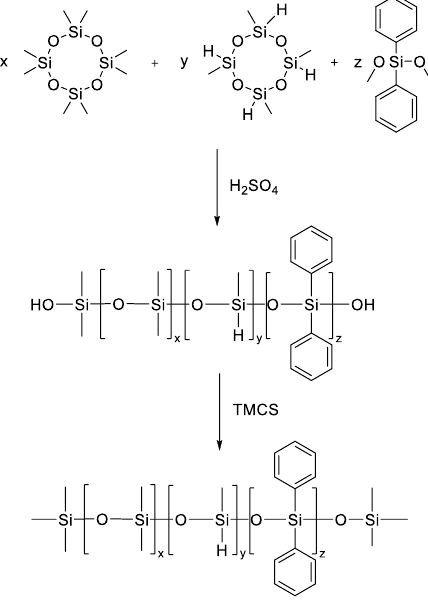
Figure 39. Synthesis of V-PDMPS.